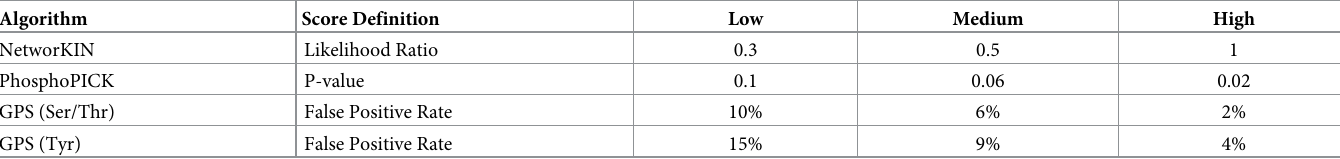
Table 1. The definition of kinase-substrate edge weights in a given prediction network and stringencies cutoffs used by algorithm for low, medium, and high stringencies.